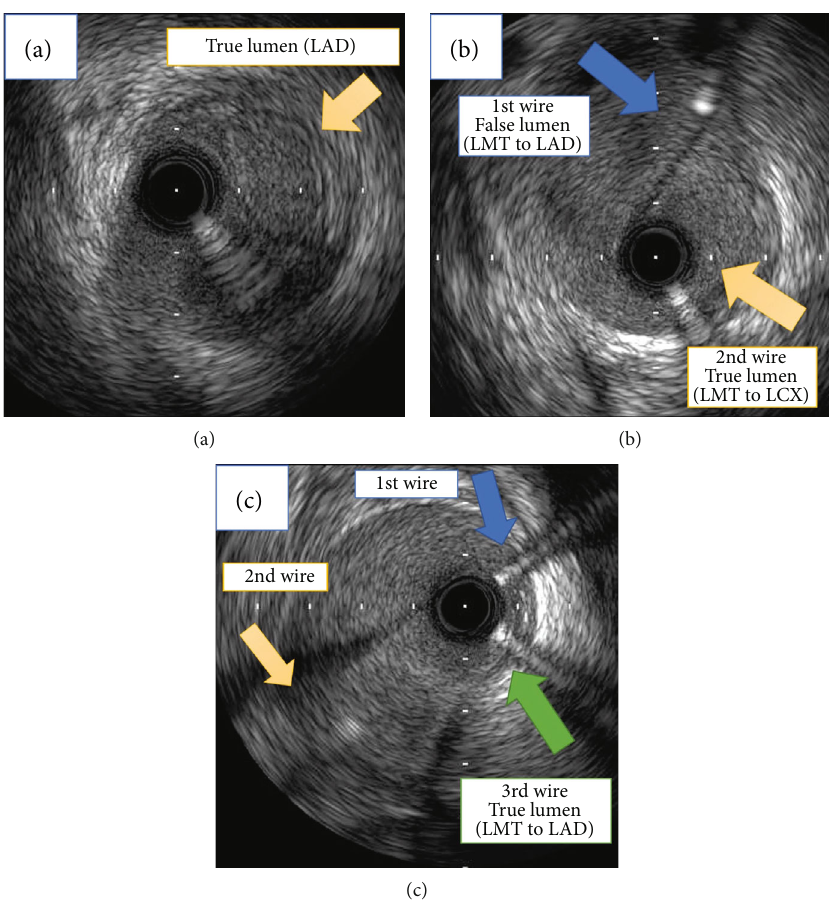
Figure 3: IVUS fi ndings during percutaneous coronary intervention. (a) The fi rst guide wire passed through the false lumen from the midportion of the LMT to the proximal site of the LAD, and the true lumen of the LAD was compressed by the enlarged false lumen (orange arrow). (b) The second guide wire was inserted into the LCX, and IVUS imaging con fi rmed that it had been placed in the true lumen from the LMT to LCX (yellow arrow). (c) The third guide wire passed entirely through the true lumen from the LMT to LAD (green arrow). LMT: left main trunk; LAD: left anterior descending artery; LCX: left circum fl ex artery; IVUS: intravascular